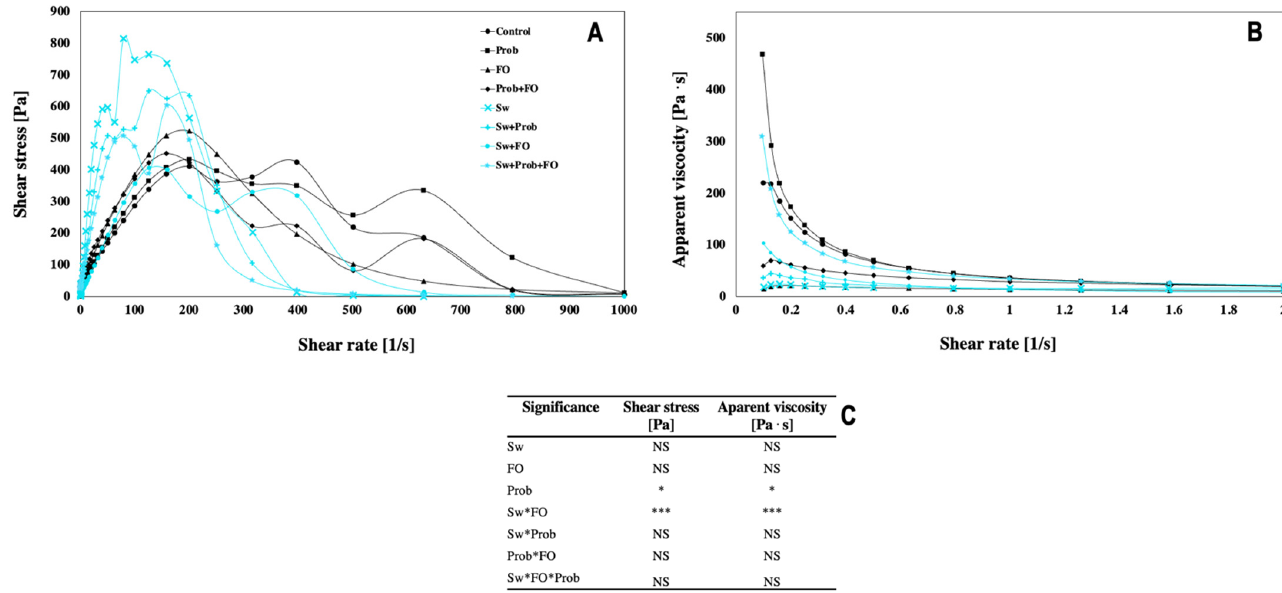
Figure 1. ( A ) Shear stresses were at a range of steady-shear rate 0.1 to 100 s − 1 and temperature 35 °C. ( B ) Apparent viscosity was at a range of steady-shear rate 0.1 to 100 s − 1 and temperature 35 °C. ( C ) Full factorial analysis of variance showing the main effects and interactions of the variables evaluated. Values represent the mean of 3 replicates. Asterisks indicate significant difference from a full factorial analysis of variance showing the main effects and interactions of the variables evaluated: * p < 0.05 , *** p < 0.001 . Sw, sweetener; FO, fish oil; Prob, probiotic; NS, non-significant. Treatments: Control = milk chocolate formulation, Prob = milk chocolate + probiotics, FO = milk chocolate + fish oil, Prob + FO = milk chocolate + probiotics + fish oil, Sw = isomalt + stevia, Sw + Prob = isomalt + stevia + probiotics, Sw + FO = isomalt + stevia + fish oil, Sw + Prob + FO = isomalt + stevia + probiotics + fish oil.